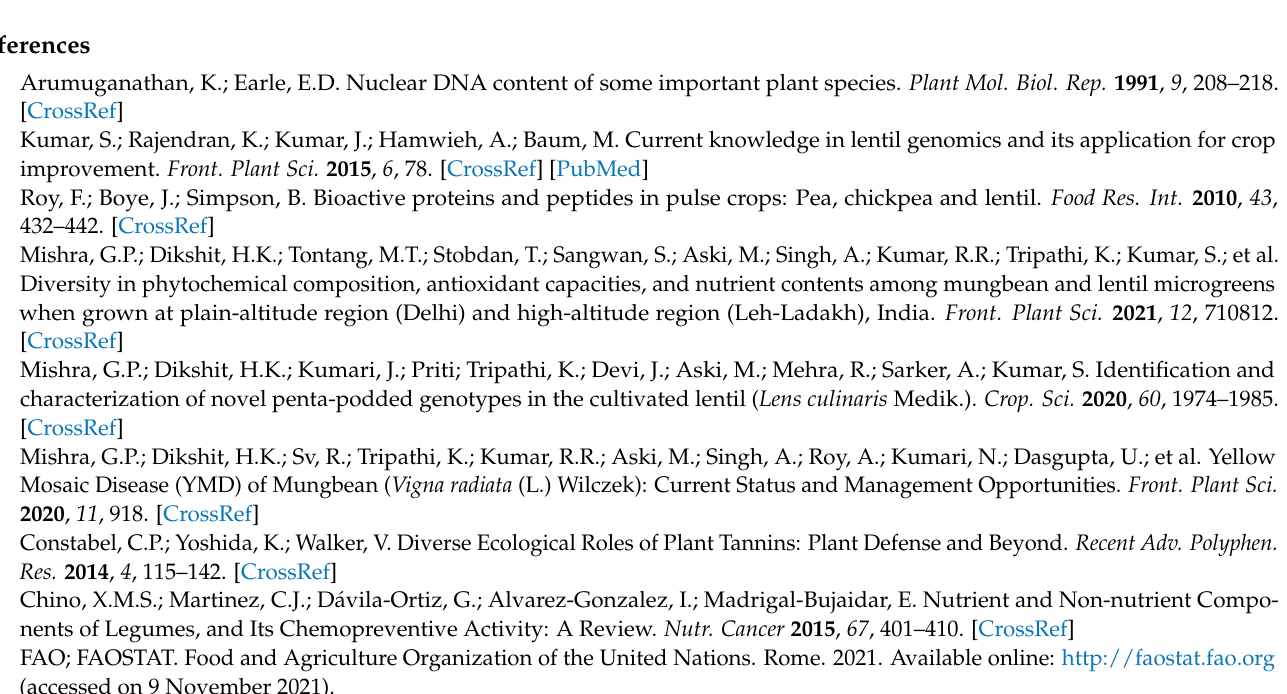
component, and (c) molecular function category from GO annotation of lentil transcriptome. Table S1: The assembled transcript summary. Table S2: The transcript expression and total number of transcripts (length ≥ 200 bp). Table S3: Annotation details using Uniprot. Table S4: Annotations details of the total DEGs with that of Rhizoctonia . Table S5: The categorization of GO terms into three major GO classes (MF, BP and CC). Table S6: KEGG pathway analysis. Table S7: PHI-base analysis of the lentil RNA Seq data. Table S8: List of miRNA target sites identified from the RNA Seq data. Table S9: Stress-associated miRNA target site